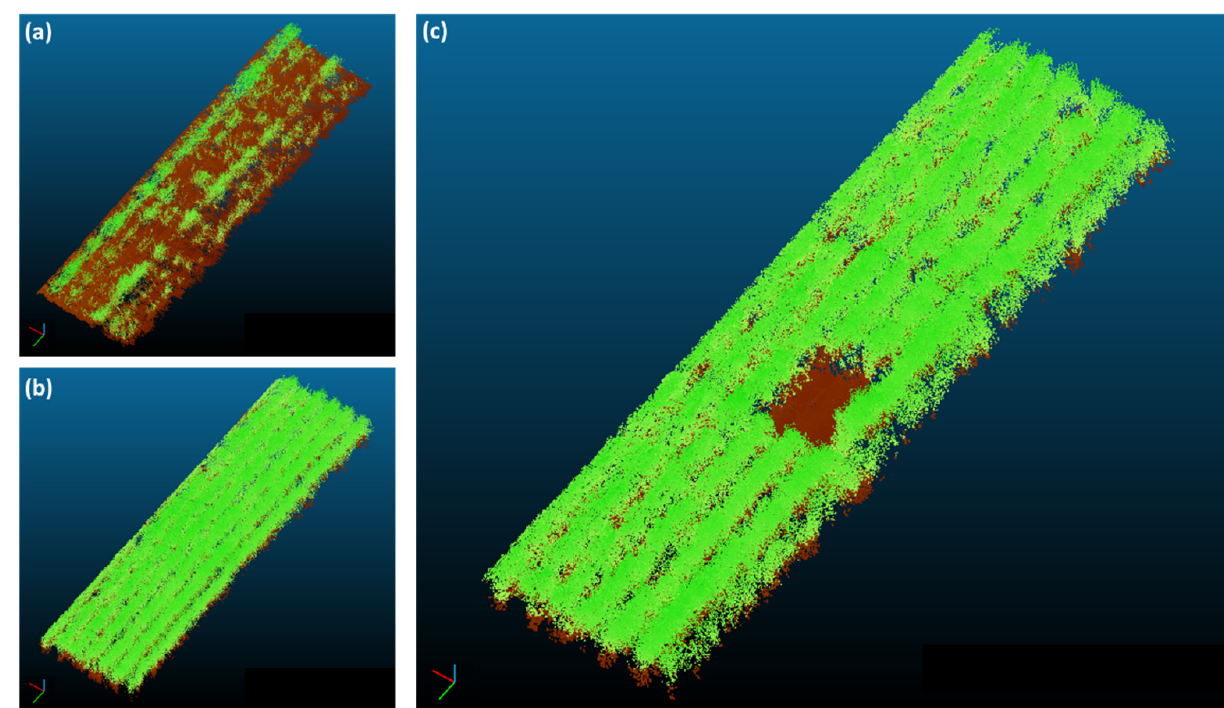
Figure 6. Processed LiDAR point cloud showing areas of low ( a ) and high ( b ) canopy coverage and detail of a plant sample cut ( c ).